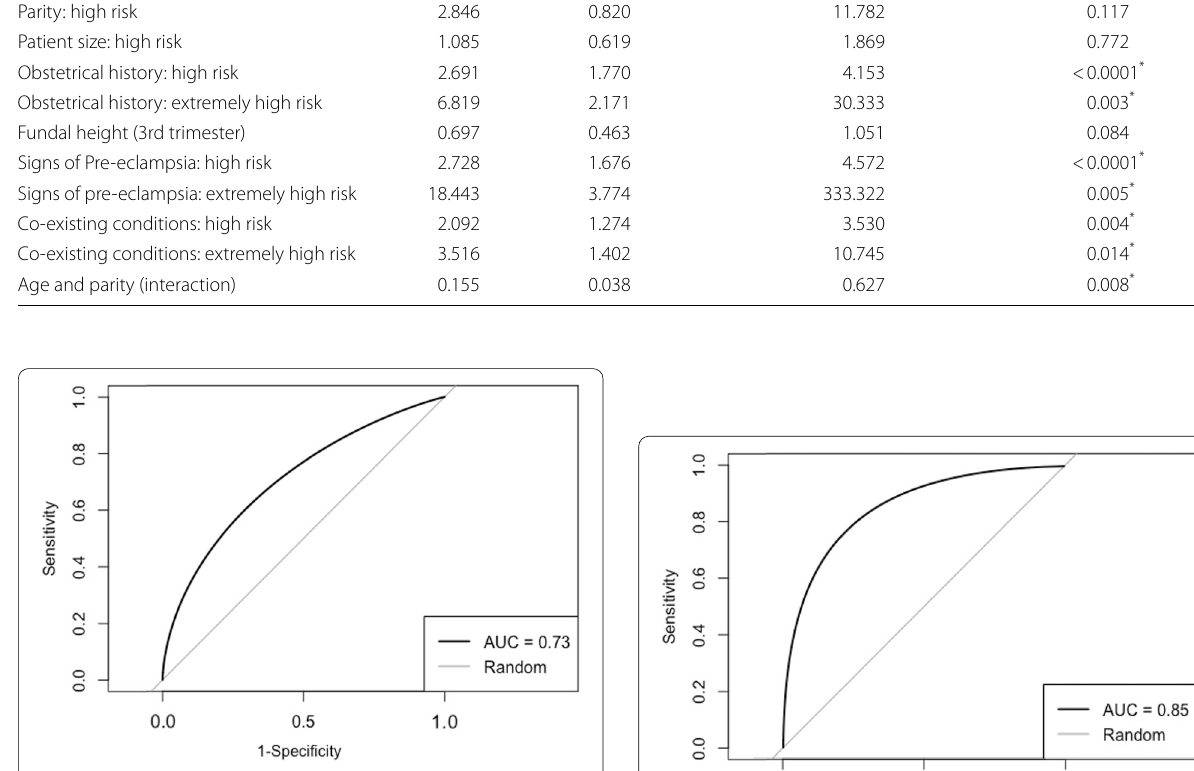
Fig. 2 Receiver operating curve and area under the curve for the CMDS with the need for a skilled birth attendant as the outcome